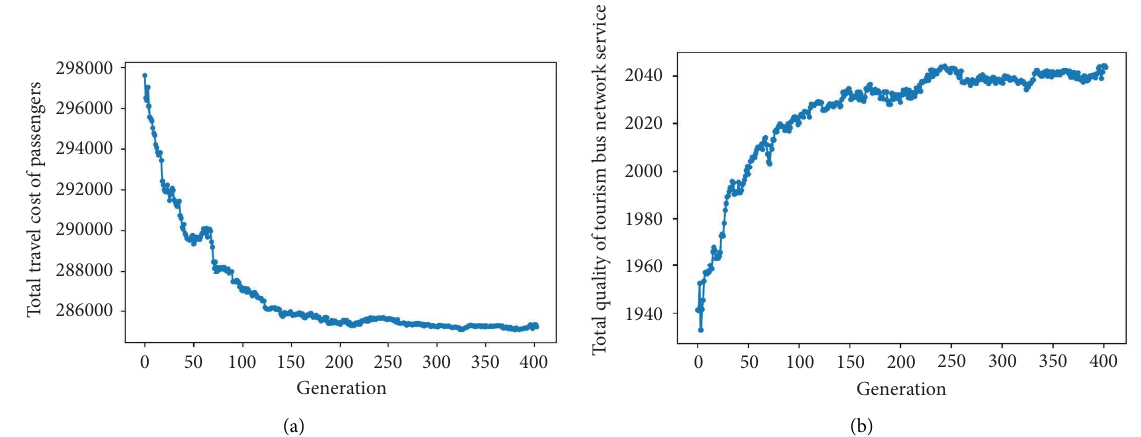
Figure 4: Convergence of diferent objectives: (a) total travel cost of tour bus passengers; (b) quality of tourism bus network